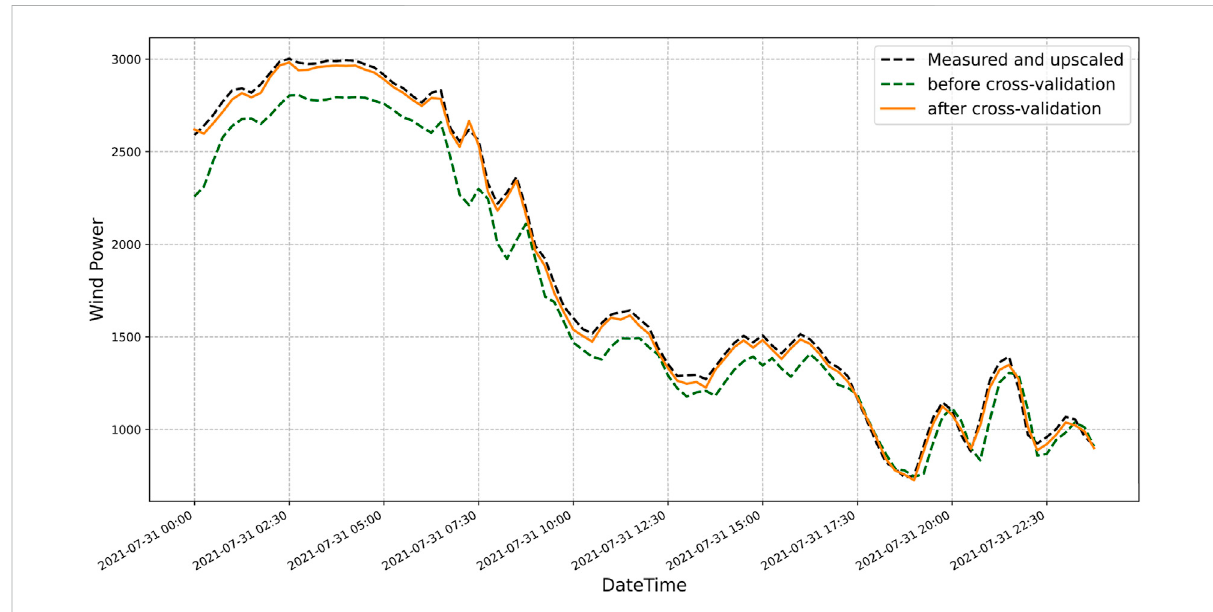
FIGURE 8 GRU predicted wind power before and after incremental